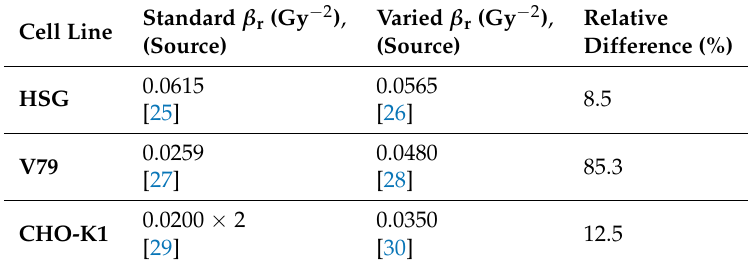
Table 5. Standard and varied β r values chosen for each cell line, with the corresponding relative differences. The numbers in square brackets are the reference